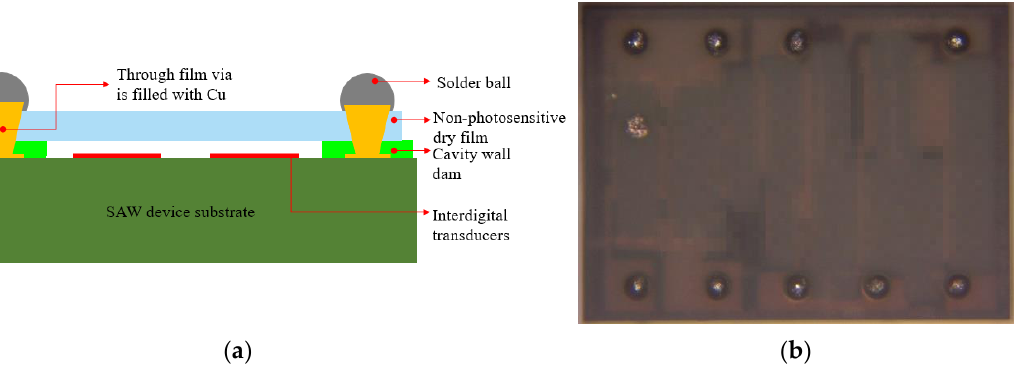
Figure 1. ( a ) The schematic of the cross-sectional SAW filter WLP structure; ( b ) the 3D WLP SAW filter ’ s top view following BGA creation.